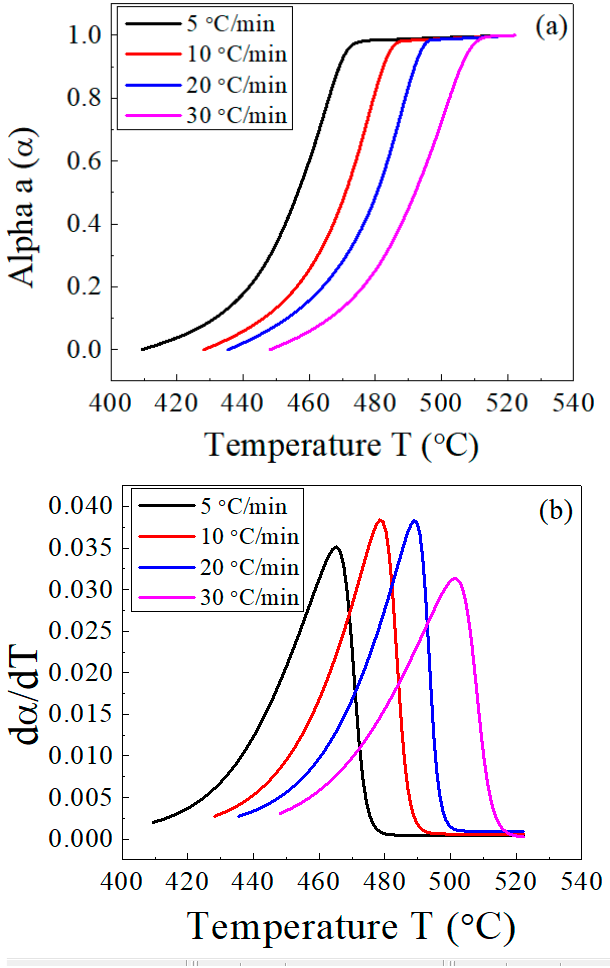
Figure 7. Temperature dependence of ( a ) the conversion, α , and ( b ) the conversion rate, da/dt, for the EPDM host composite sample.